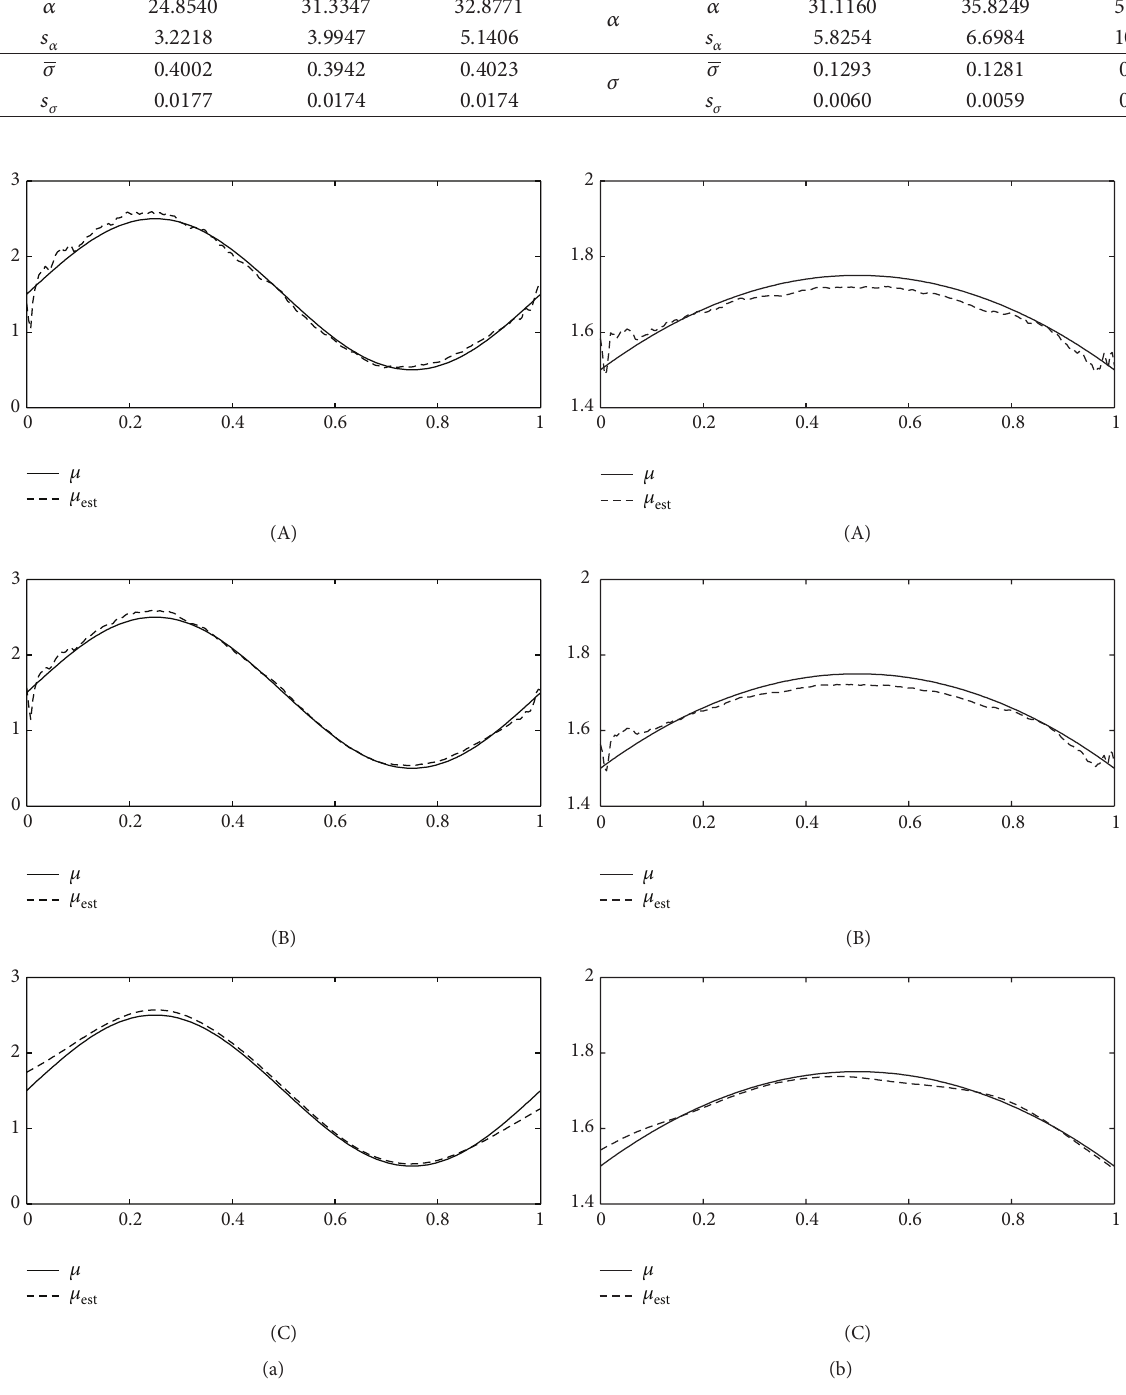
Figure 3: Estimated 𝜇 1 (𝑡) and 𝜇 2 (𝑡) . The left side correspond to Case 1 (sinusoidal) and the right side to Case 2 (parabolic). The (A) plots are obtained with the convolution (𝑐 1 𝑘 ) , (B) plots with (𝑐 3 𝑘 ) and (C) plots with (𝑐 hp 𝑘 ) . The parameters involved in this figure are presented in Tables 1 and